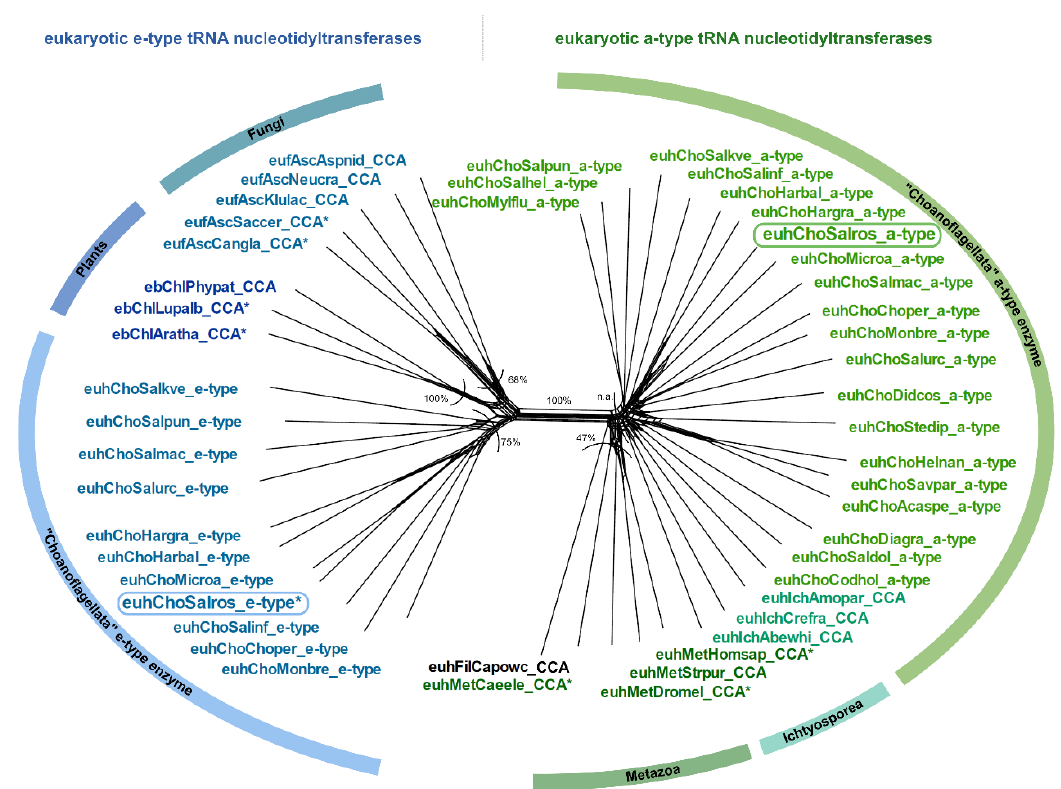
Figure 2. Phylogenetic network of a- and e-type tRNA nucleotidyltransferase sequences from Choanoflagellata. On the right of the main split, a-type sequences of CCA-adding enzymes from Metazoa cluster with a-type sequences from Choanoflagellata (CC-adding enzyme in S. rosetta ). On the left of the main split, e-type enzyme sequences from Fungi and Plants cluster with candidate e-type enzyme sequences of Choanoflagellata (A-adding enzyme in S. rosetta ). An asterisk (*) marks sequences with experimentally verified function. Frames indicate the enzymes of S. rosetta that were analyzed in this study. Bootstrap values are indicated as percentage values, n.a. represents no shared split. Sequence names consist of the taxonomic group prefix (eu—Eukaryota, Unikonta; euh—Eukaryota,